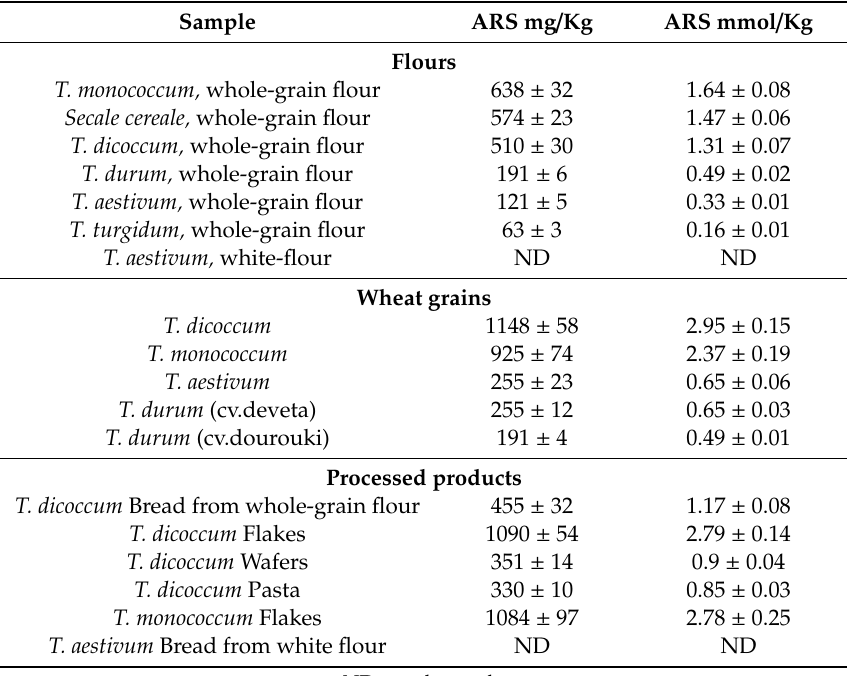
Table 1. Concentration of total alkylresorcinols in flours, grains and processed